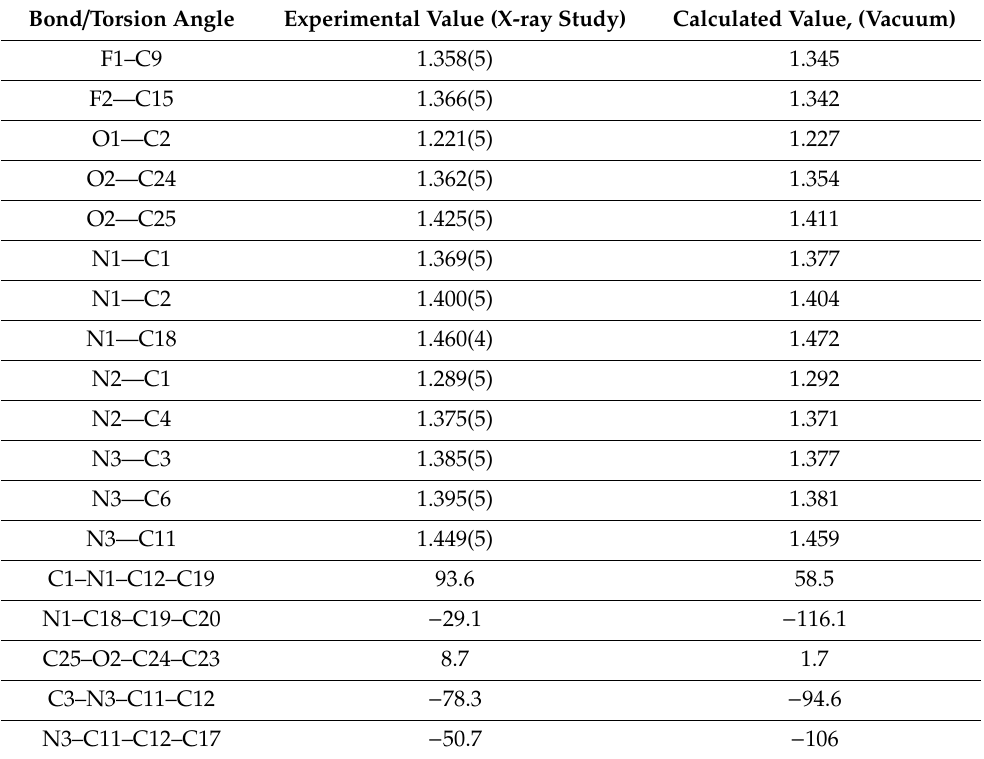
Table 2. Geometrical parameters of the title compound (bond lengths in Å, torsion angles presented in degrees, numeration of atoms according to Figure 2).